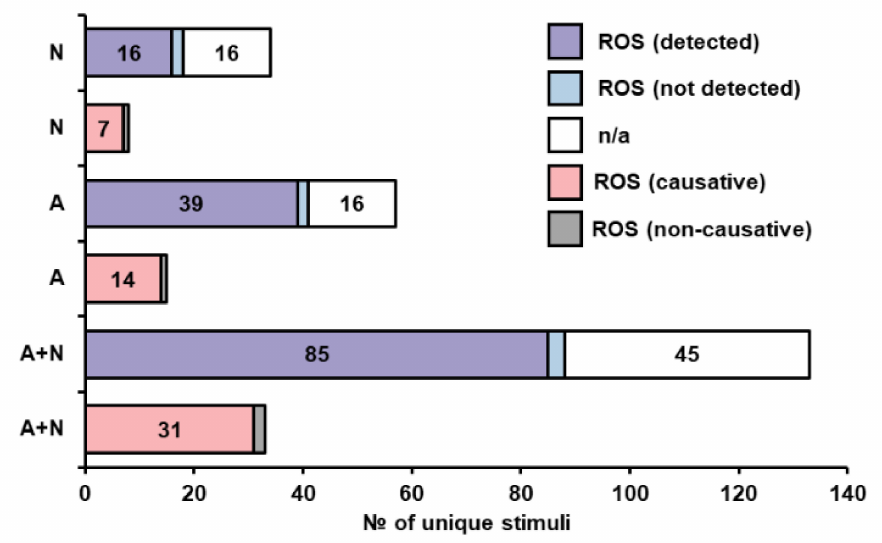
Figure 5. ROS generation and its role in cell death caused by various stimuli. Generation of reactive oxygen species are common features of cell death in yeast cells, whether it is necrotic, apoptotic, or mixed death. A + N—Apoptosis and necrosis hallmarks observed together; A—exclusive apoptosis; N—exclusive